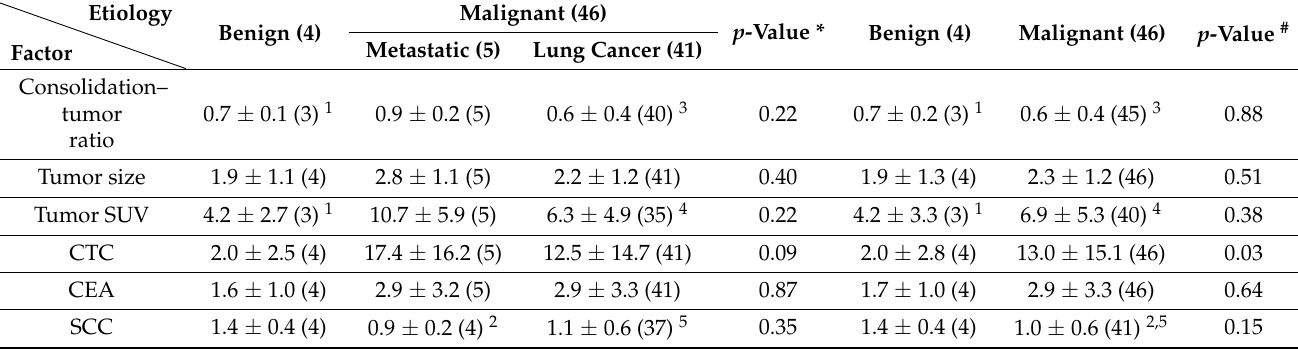
Table 2. Comparative presentations of benign and malignant pulmonary lesions.